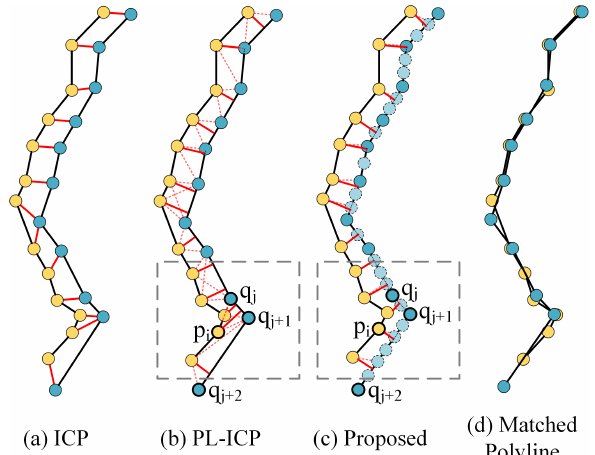
Figure 5. The comparison of the distance metric between polylines adopted by various methods, where the polyline represented by yellow nodes is the target polyline, and the polyline represented by blue nodes is the reference